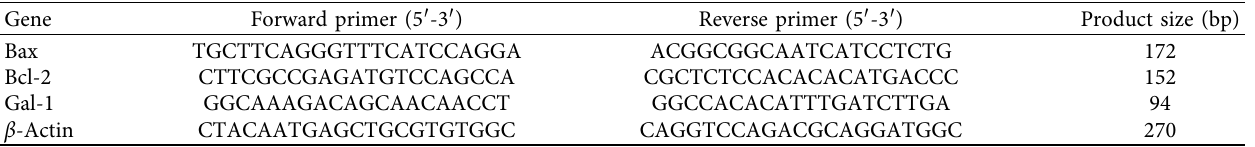
Table 1: Nucleotide sequences of the